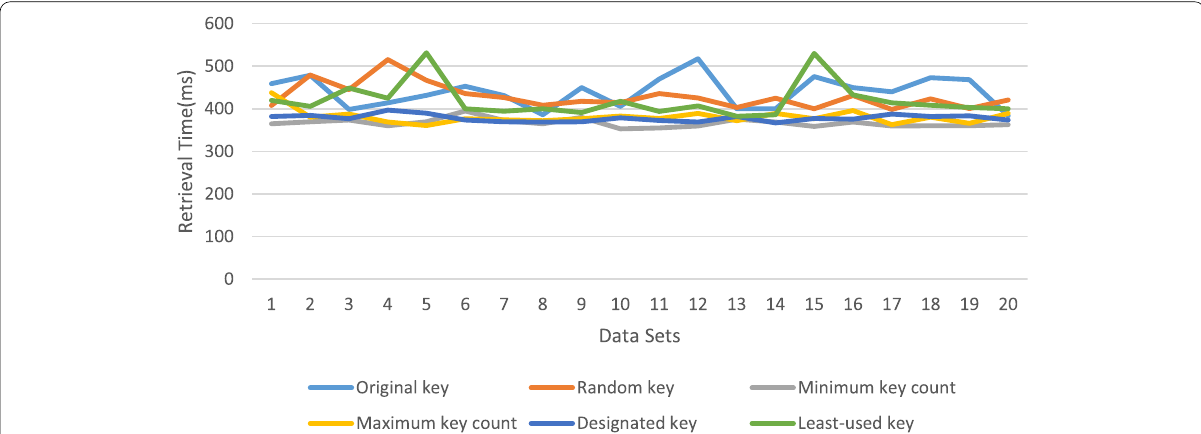
Fig. 10 Retrieval time on primary index models generated using the six different key selection methods with unequal appearing probabilities of parameters in services inputs